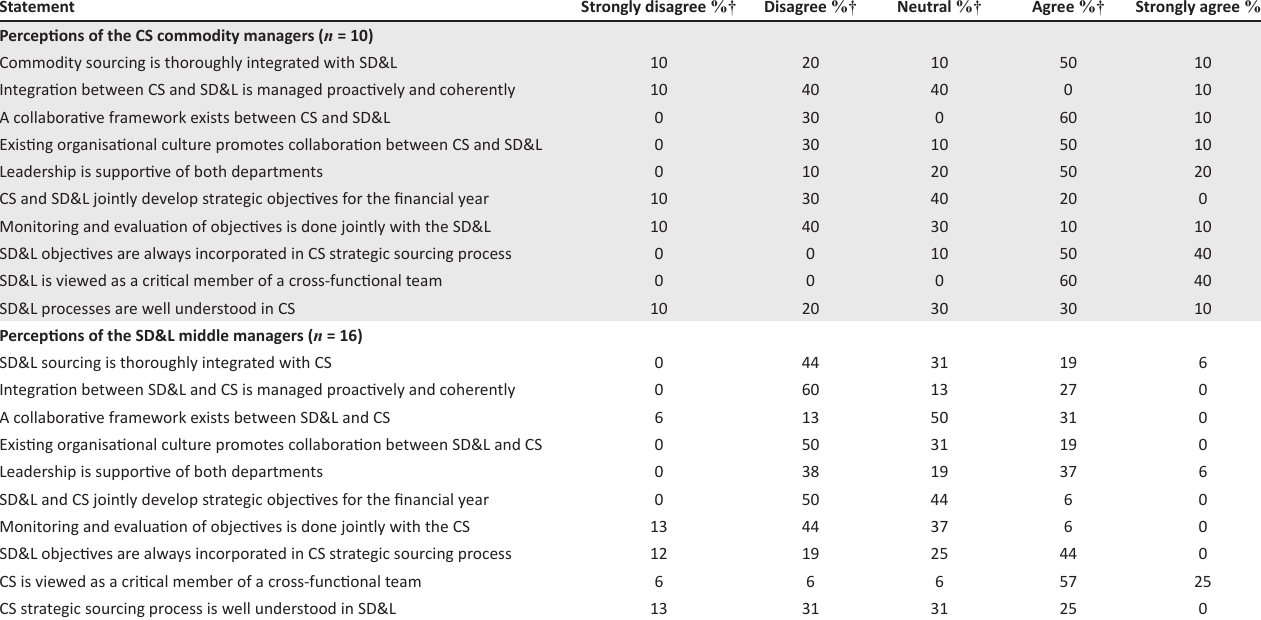
TABLE 2: Perceptions of Commodity Sourcing and Supplier Development and Localisation managers regarding strategic sourcing as a catalyst.